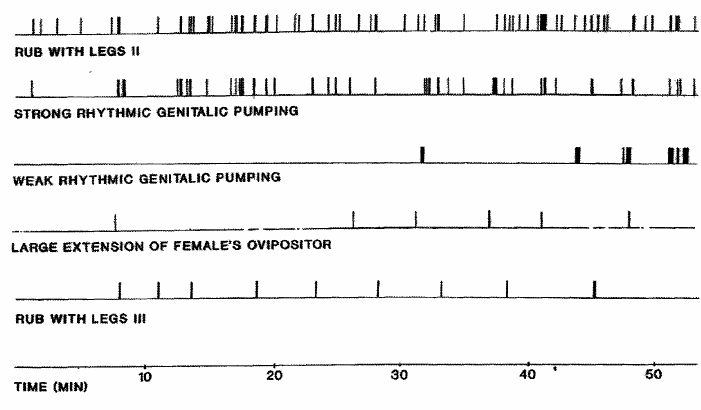
Fig. 9. Male behavior during a copulation lasting 54 min. The widths of the bars indicate the duration of different activities. original position) that the "thrusts" were actually brief, rhythmic pulls on the aculeus, and that after each pull the aculeus was retracted by the female(?) back into her body. Occasionally the male pulled forcefully and extended her ovipositor briefly (Fig.